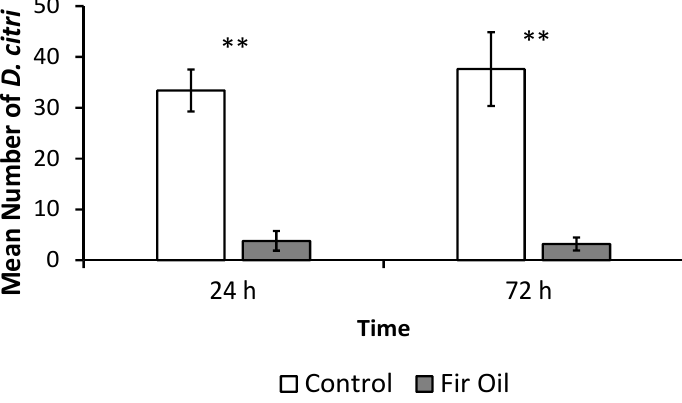
Figure 1. Mean (±SE) number of Diaphorina citri settling per plant on citrus seedlings treated with fir oil after 24 and 72 h as compared with blank control seedlings in a choice bioassays ** <0.01. Table 3. Relative peak area (%), and Kovats retention indexes (KRI) of compounds comprising fir oil used in these experiments.